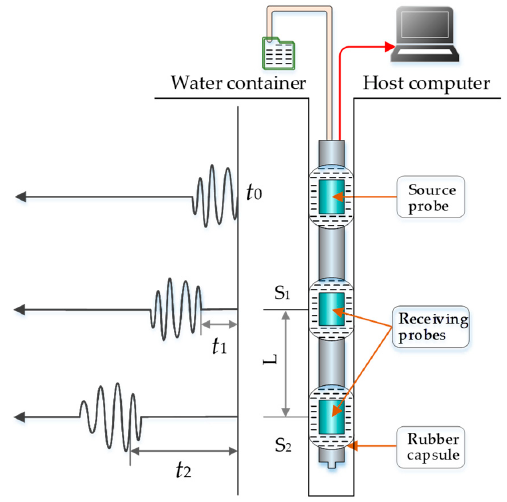
Figure 2. Principle of ultrasonic testing.